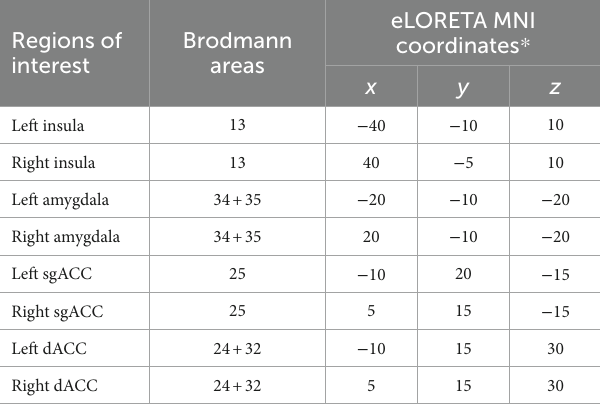
MNI, montreal neurological institute; eLORETA, exact low-resolution brain electromagnetic tomography software; sgACC, subgenual anterior cingulate cortex; and dACC, dorsal anterior cingulate cortex. * eLORETA ROIs coordinates